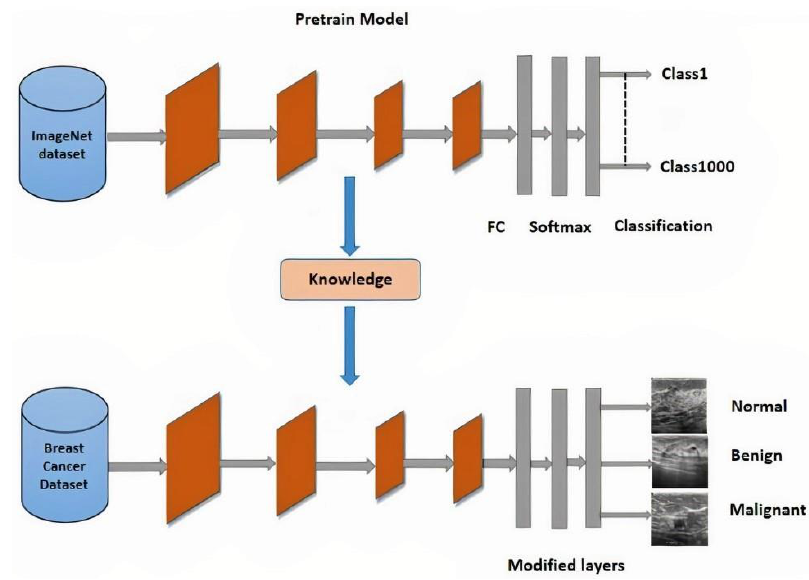
Figure 3. TL of Pretrain models.